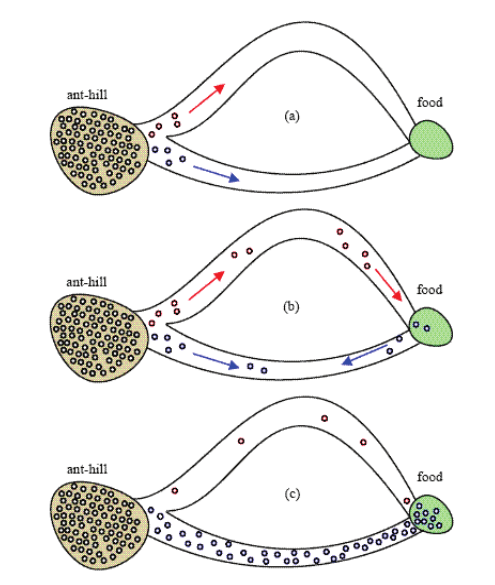
Fig. 1 Ants optimizing the food